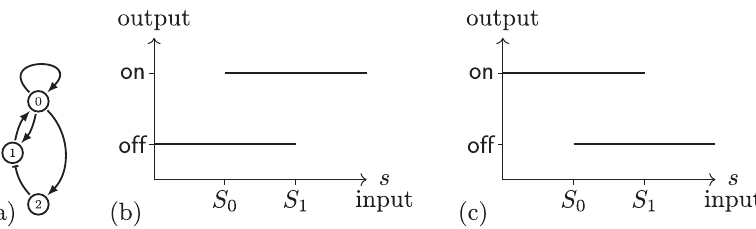
Fig 1. (a) Regulatory network 107. There are three nodes labelled 0, 1, and 2. Edges ! indicates up regulation and a indicates down regulation. (b) Conceptual image of ascending hysteresis. Off/low output for low values of input signal s . On/high output for high values of s . Bistability for intermediate values of s allowing for hysteresis. (c) Descending hysteresis. Results, analogous to those for ascending hysteresis, are discussed in Section